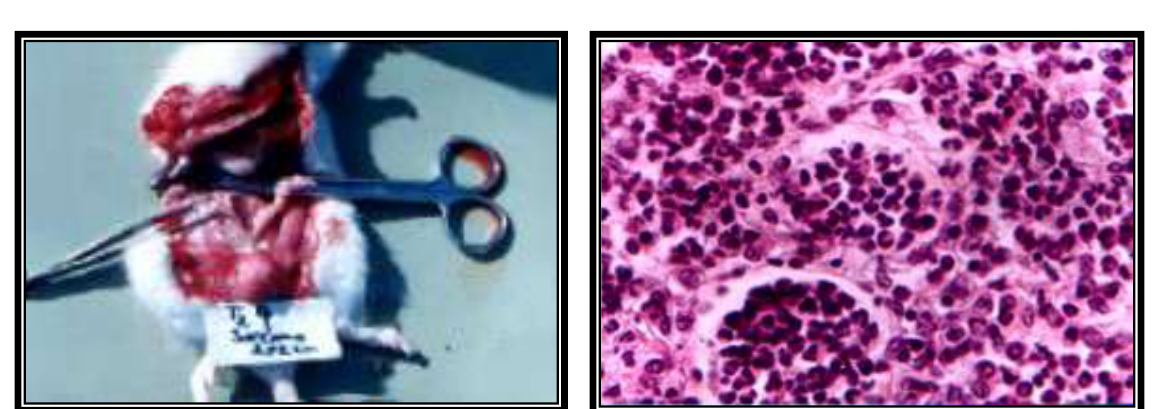
Figure 1 : cross section in rat liver (T1) observe necrosis. H& E X 40